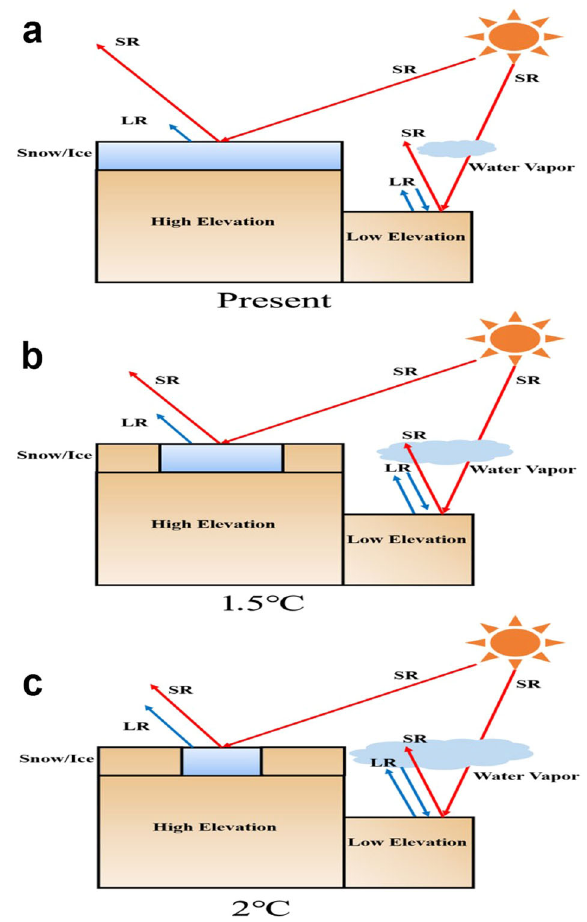
Fig. 6 Schematic fi gure of possible mechanisms responsible for robust elevation-dependent warming over the Tibetan Plateau at GW1.5 and GW2. SR and LR indicate shortwave radiation and longwave radiation fl uxes, respectively. It is adapted from Fig. 10 of You et al.